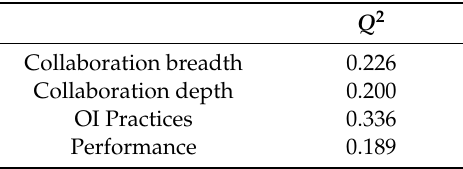
Table 16. Predictive capacity ( Q 2 ) values.